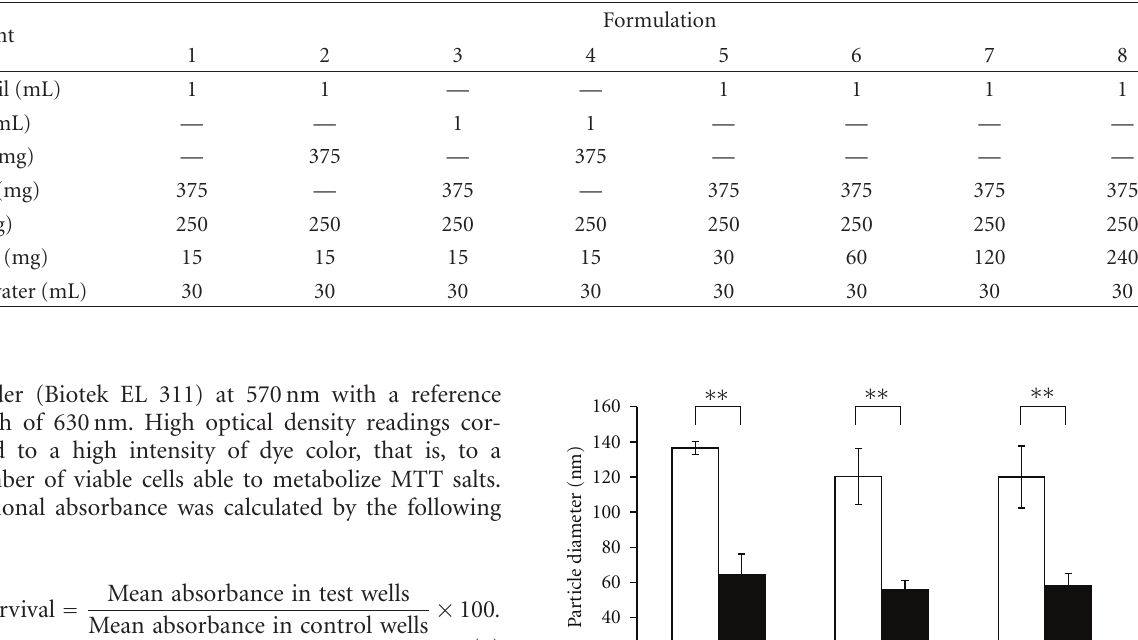
Table 1: Formulations of curcumin-loaded lipid nanoemulsion.